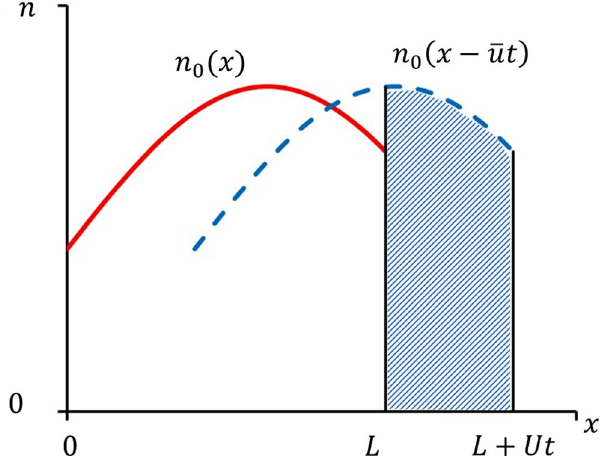
Figure 4. Illustration of spatiotemporal evolution of the second term on the right hand side of Eq. (9). An arbitrary initial distribution is shown by the solid (red) curve. The distribution after time, t is shown by the dashed (blue) curve. For a uniform sliding speed u , the distribution after time t will be the initial distribution function shifted along the positive x axis by ut . Since = x L represent the location of the navel, the number of lint fibers accrued in the navel during this time interval will be the area of the shaded portion.